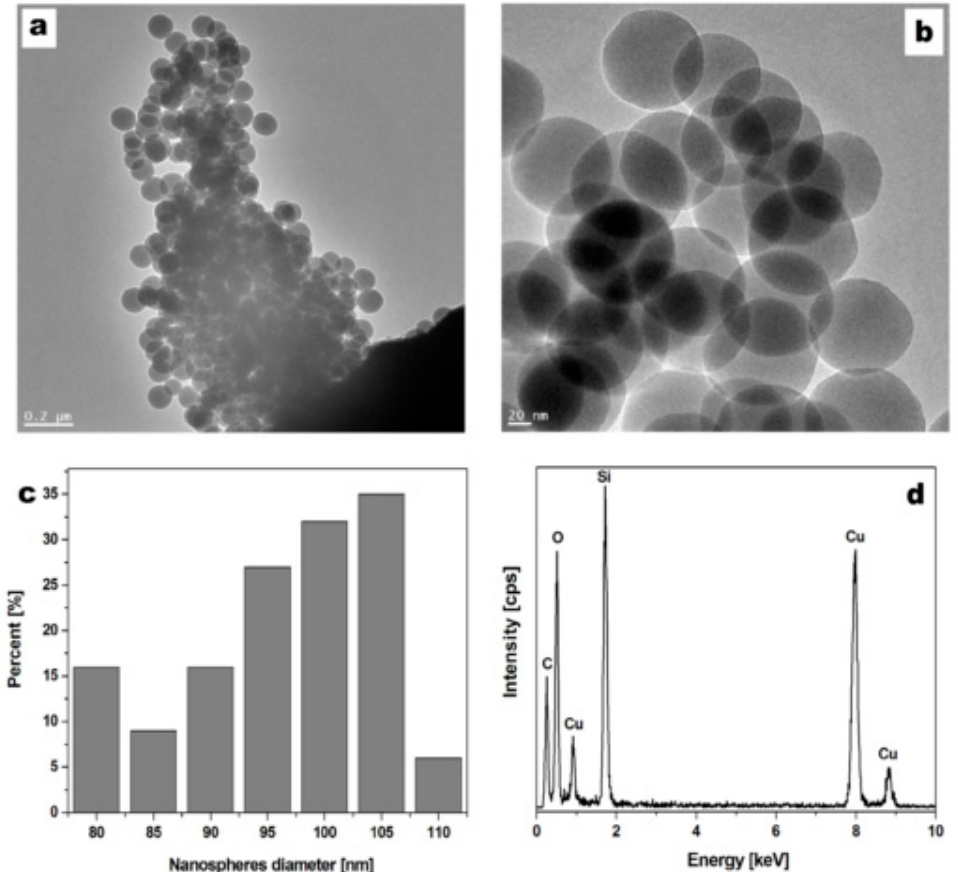
Figure 1. Transmission electron microscope (TEM) images ( a , b ), diameter size distribution ( c ), and X-ray energy dispersive spectroscope (EDX) spectrum ( d ) of the silica